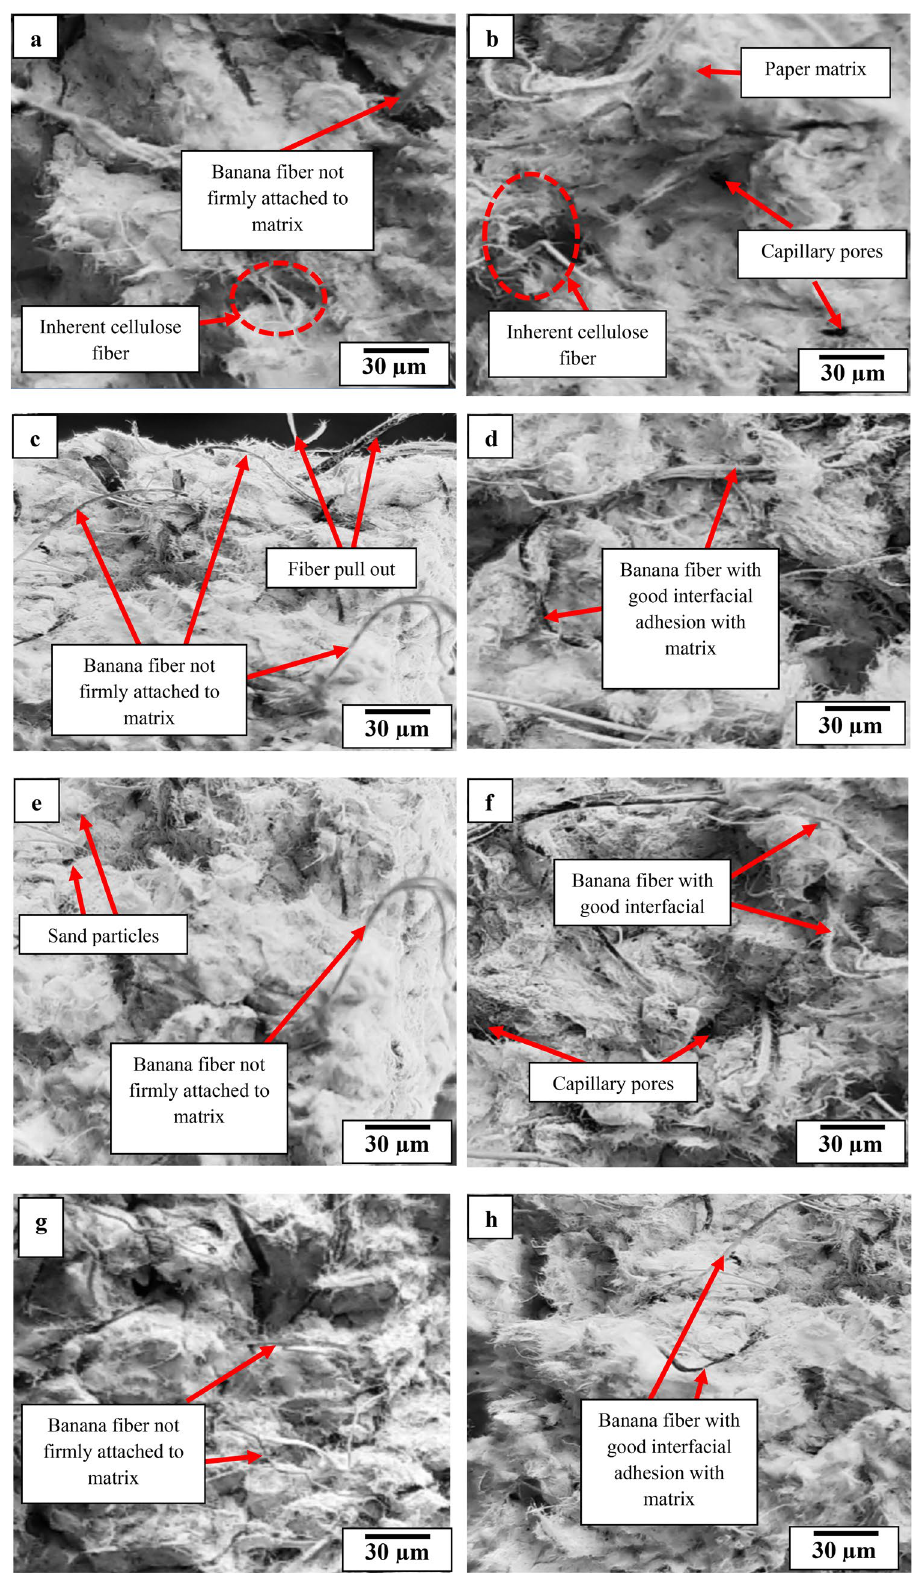
Figure 11. Scanning electron micrograph images of paperbricks (cured for 56 days) containing varying amount of unmodified banana fiber (0.5, 1.0, 1.5, 2.0, and 2.5 wt%) represented in ( a , c , e , f , g , i ) respectively and modified banana fiber (0.5, 1.0, 1.5, 2.0, and 2.5 wt%) represented in ( b , d , f , h , j